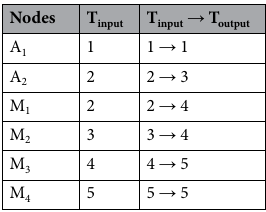
Table 1. Life time table of Block 1.